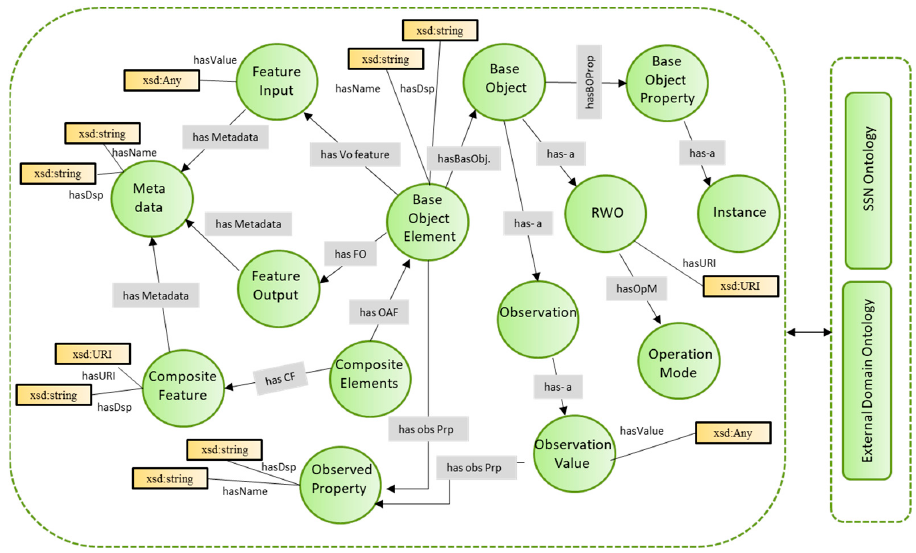
Figure 6. Base ontology model conceptualization.